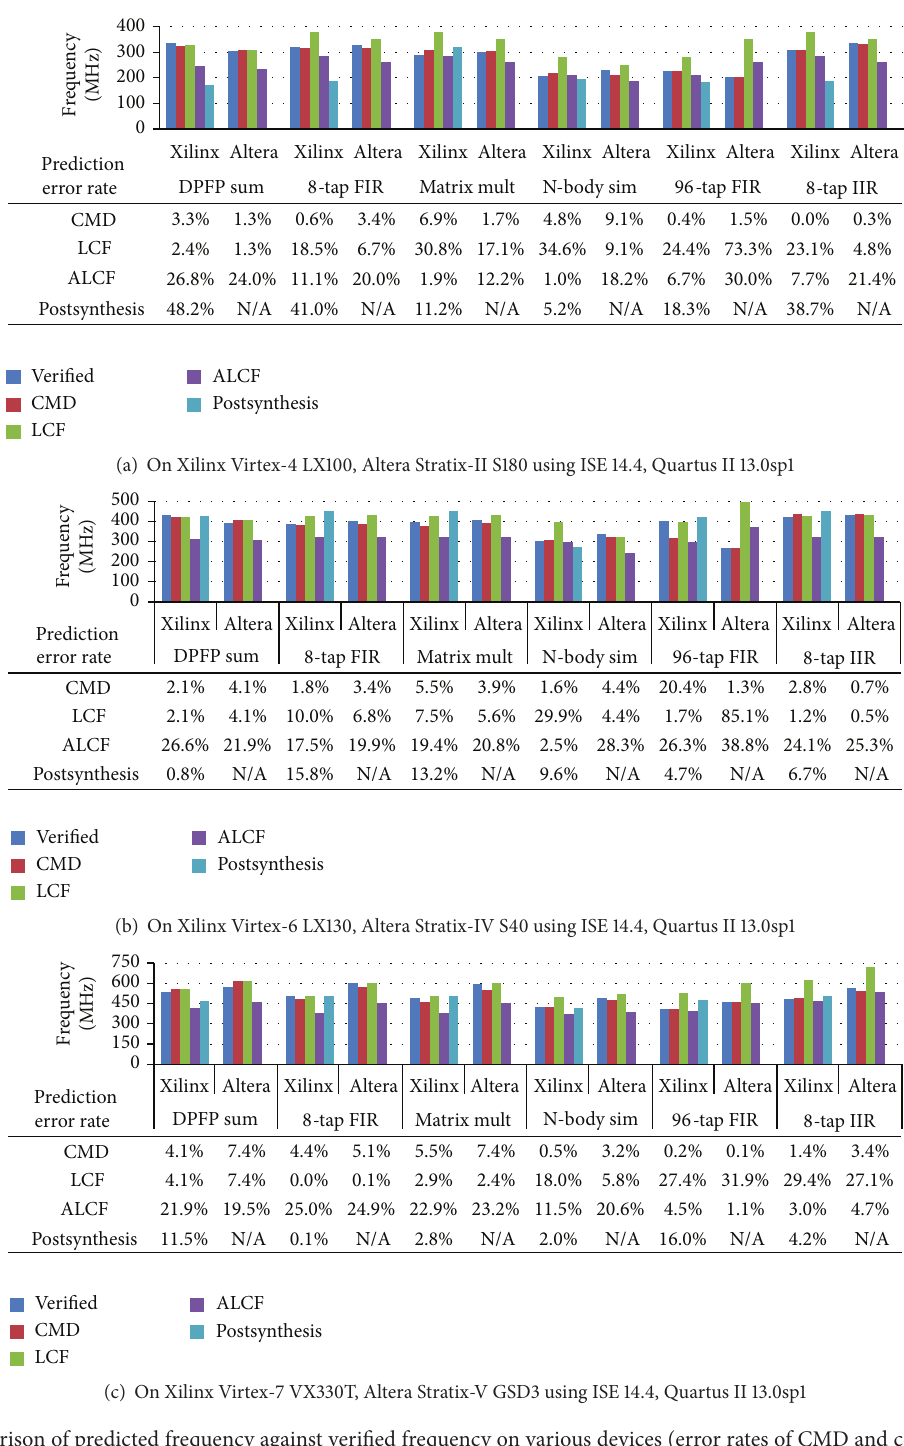
Figure 14: Comparison of predicted frequency against verified frequency on various devices (error rates of CMD and compared high-level methods are summarized in tabular